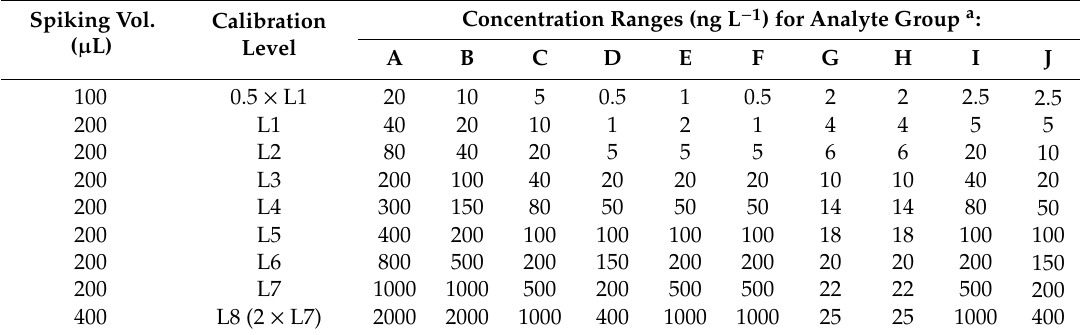
a Analytes within each concentration range group are as described in Section